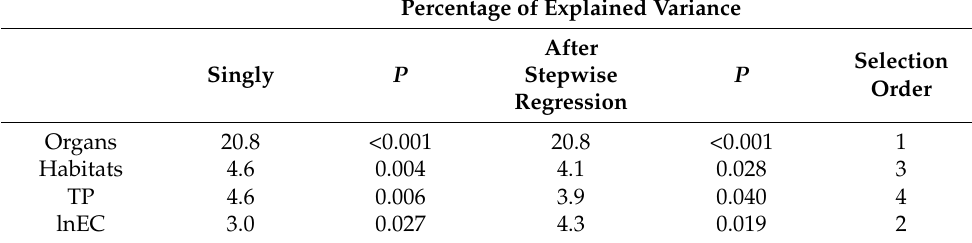
Table 3. Percentage of variance in plant nutrient concentrations (C, N, P) and stoichiometry (C:N:P) explained by organs (root versus shoot), habitats (lake versus river) and environmental variables (water and sediment chemistry) using redundancy analyses: singly and after stepwise selection. Only significant explanatory variables are shown. n = 80, missing data were replaced by averages across all samples. TP = total P, EC = electric